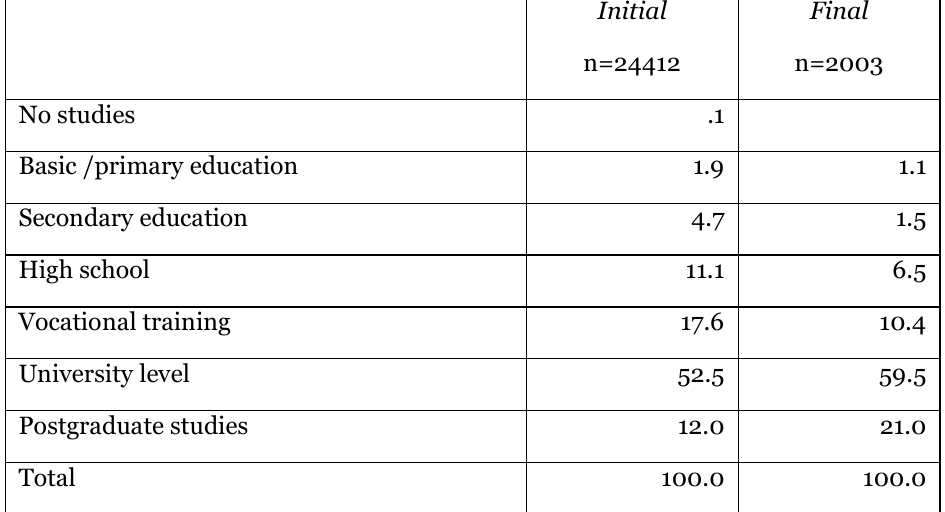
Percentage Distribution of Samples by Level of Education (Completed or in Progress)